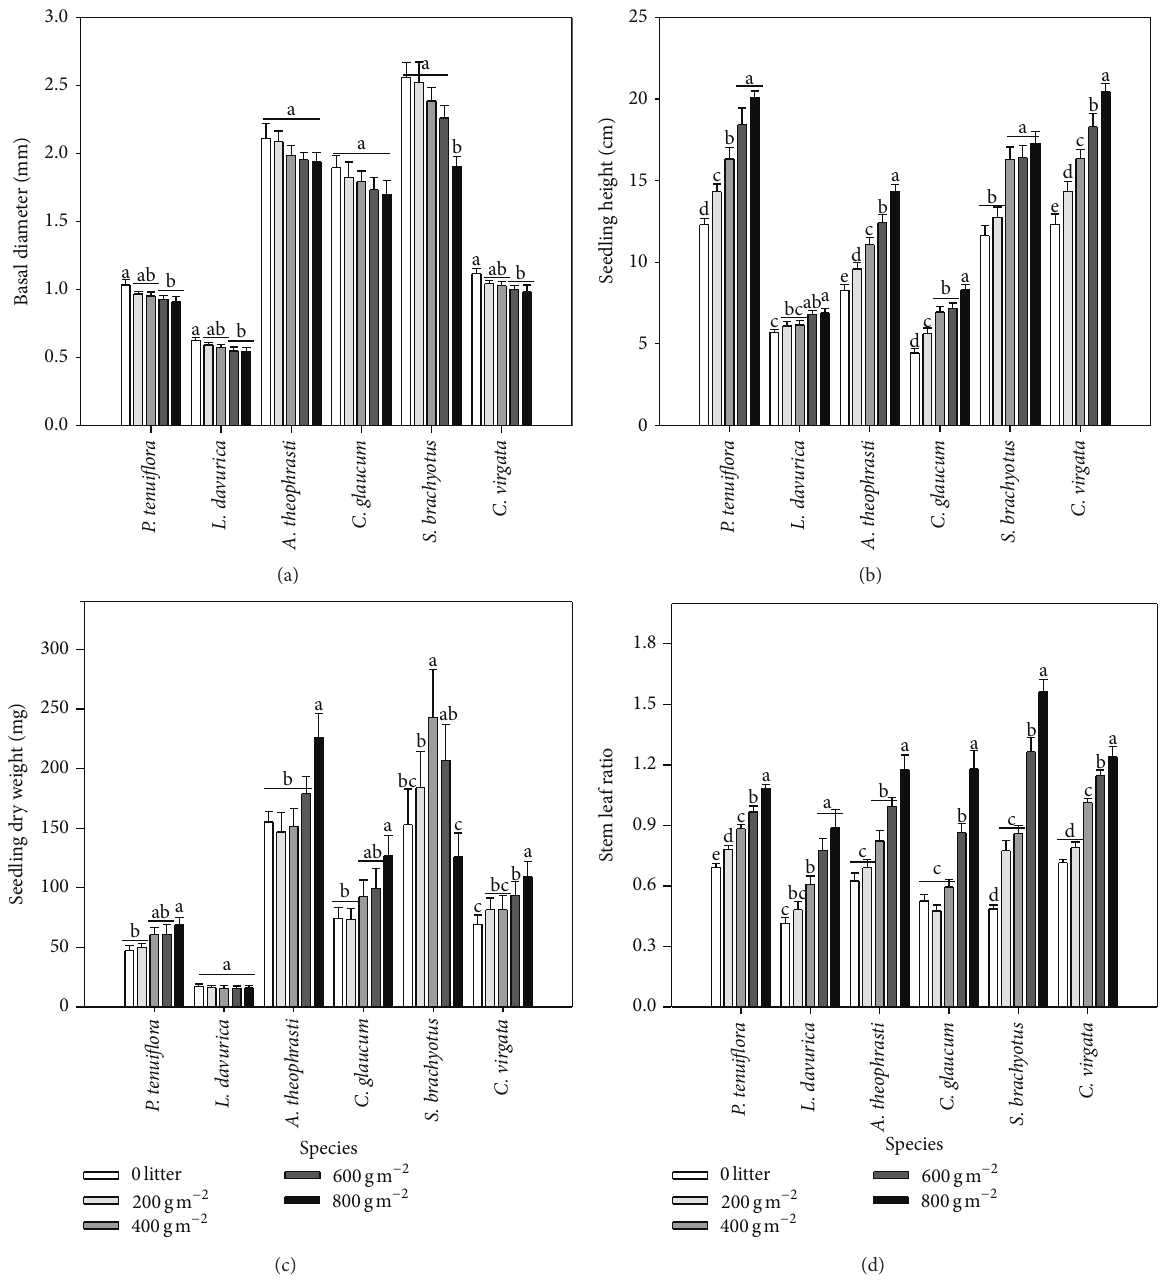
Figure 5: Seedling basal diameter (a), height (b), dry weight (c), and stem leaf ratio (d) under different species and litter cover. The values were represented as mean + SE; different letters indicate significant difference between treatments at 𝑃 < 0.05